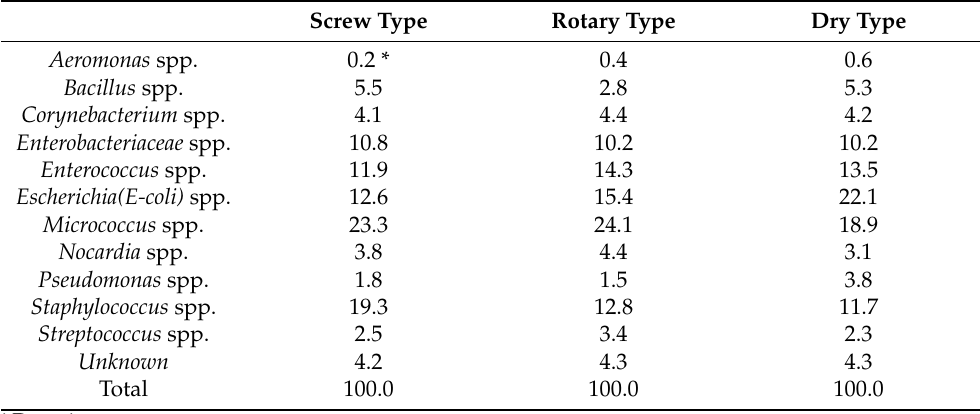
Table 3. Identification of Airborne Bacteria in Swine Manure Composting Plants (Unit: %). Screw Type Rotary